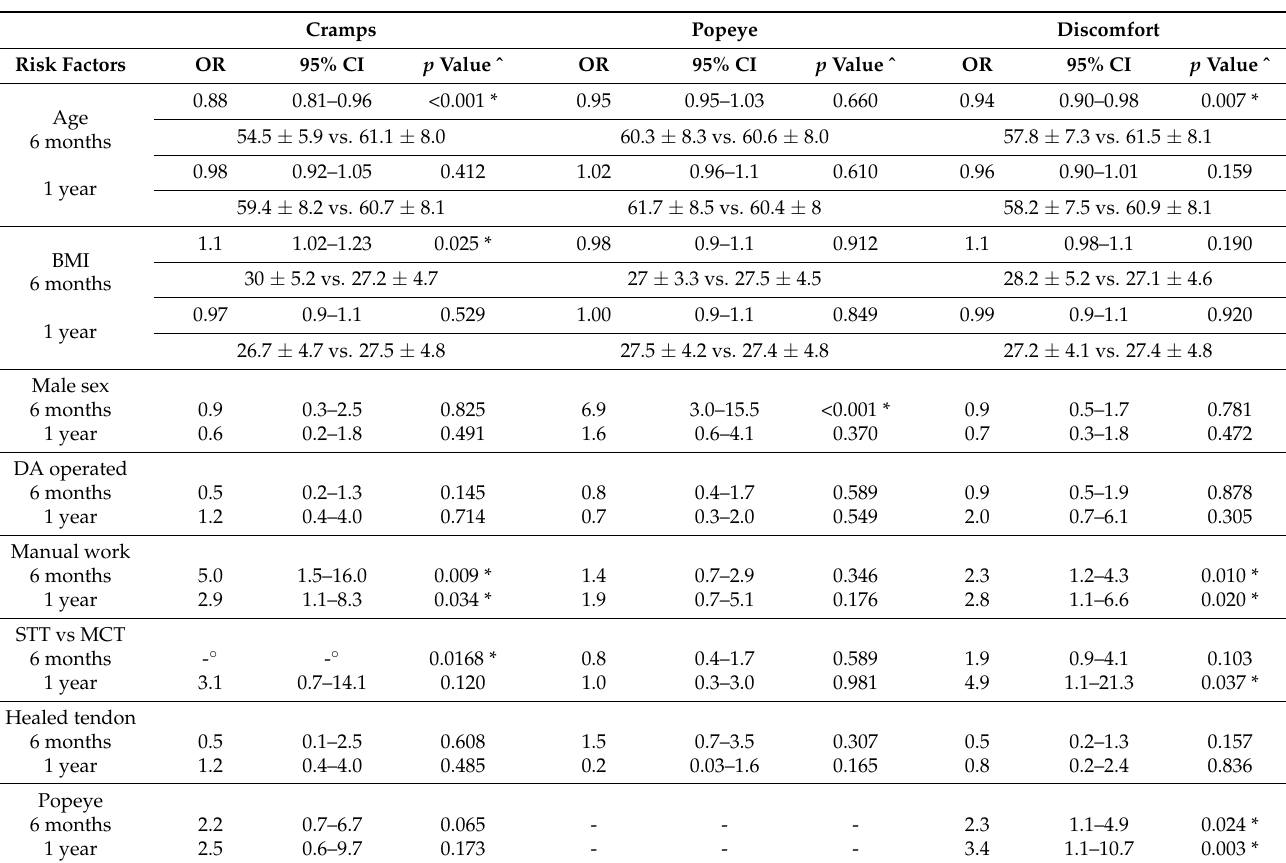
Table 3. Risk factors for